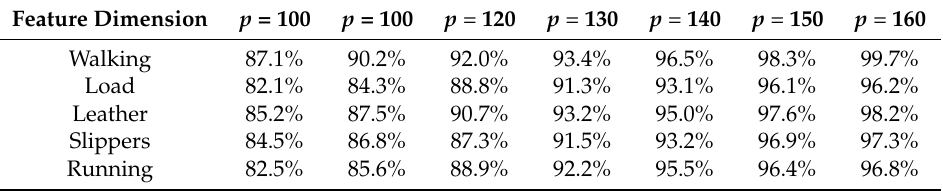
Table 3. Recognition rate of the proposed method on different sequences in our